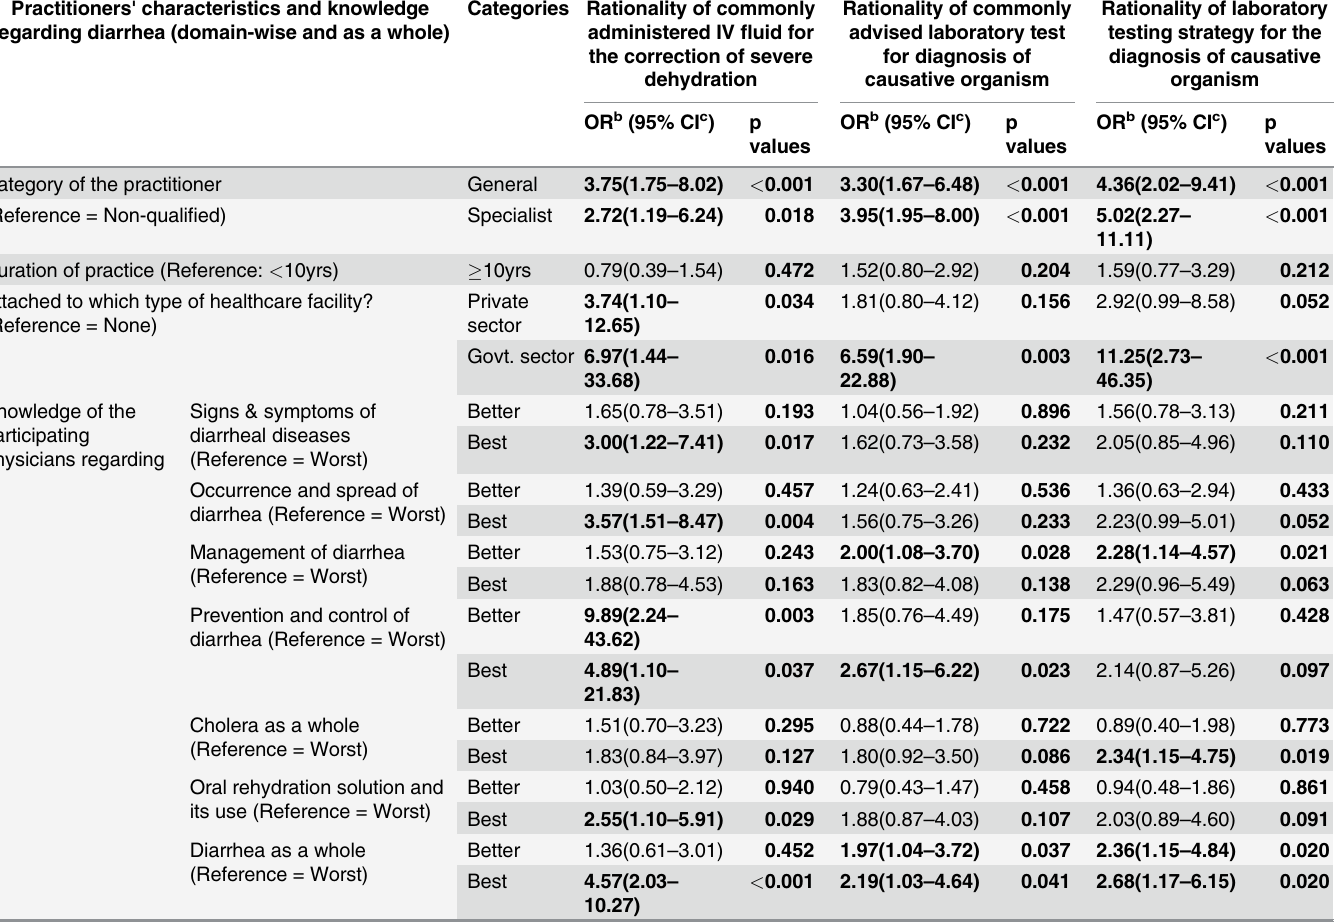
Table 3. Association of physician ’ s characteristics and knowledge regarding diarrhea with rationality of fluid management and laboratory testing practices while treating diarrhea cases (N a =